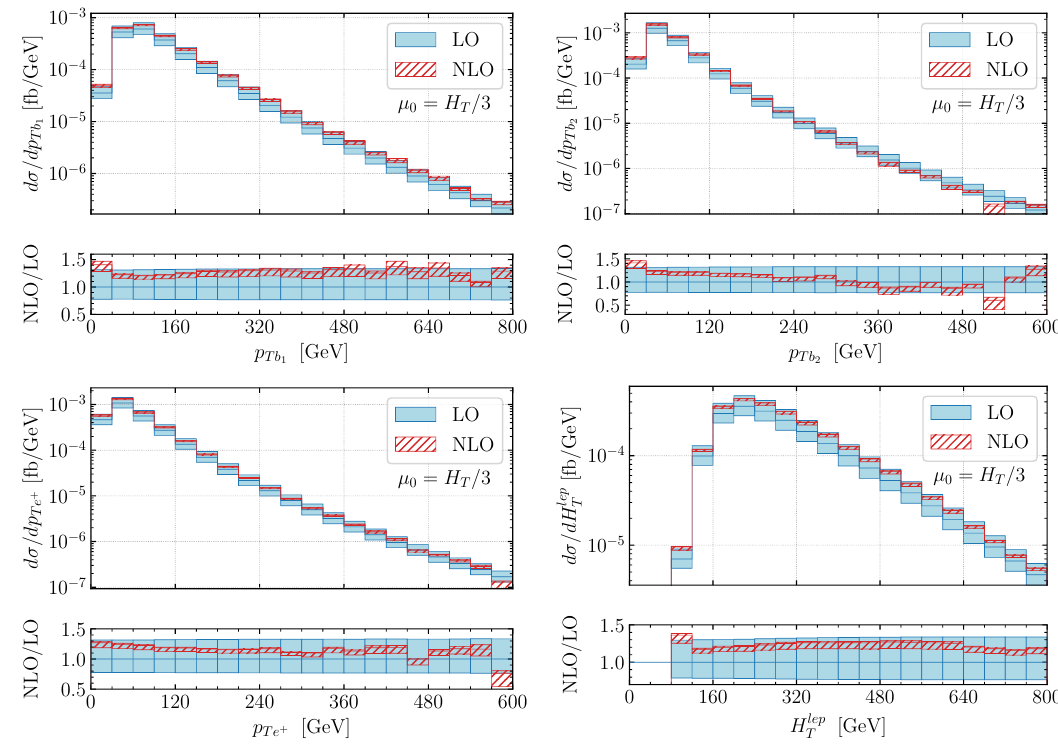
Figure 7 . Differential cross-section distributions for pp → e + ν e µ − ¯ ν µ b ¯ b τ + τ − + X at the LHC √ with s = 13 TeV as a function of p T b , p T b , p and H lep . The blue curve corresponds to T e + T 1 2 the LO and the red curve to the NLO result. Also shown are the corresponding uncertainty bands resulting from scale variations. The lower panels display the differential K -factor together with the uncertainty band and the relative scale uncertainties of the LO cross section. The scale choice is µ R = µ F = µ 0 = H T / 3 . The cross sections are evaluated with the NNPDF3.1 PDF sets.